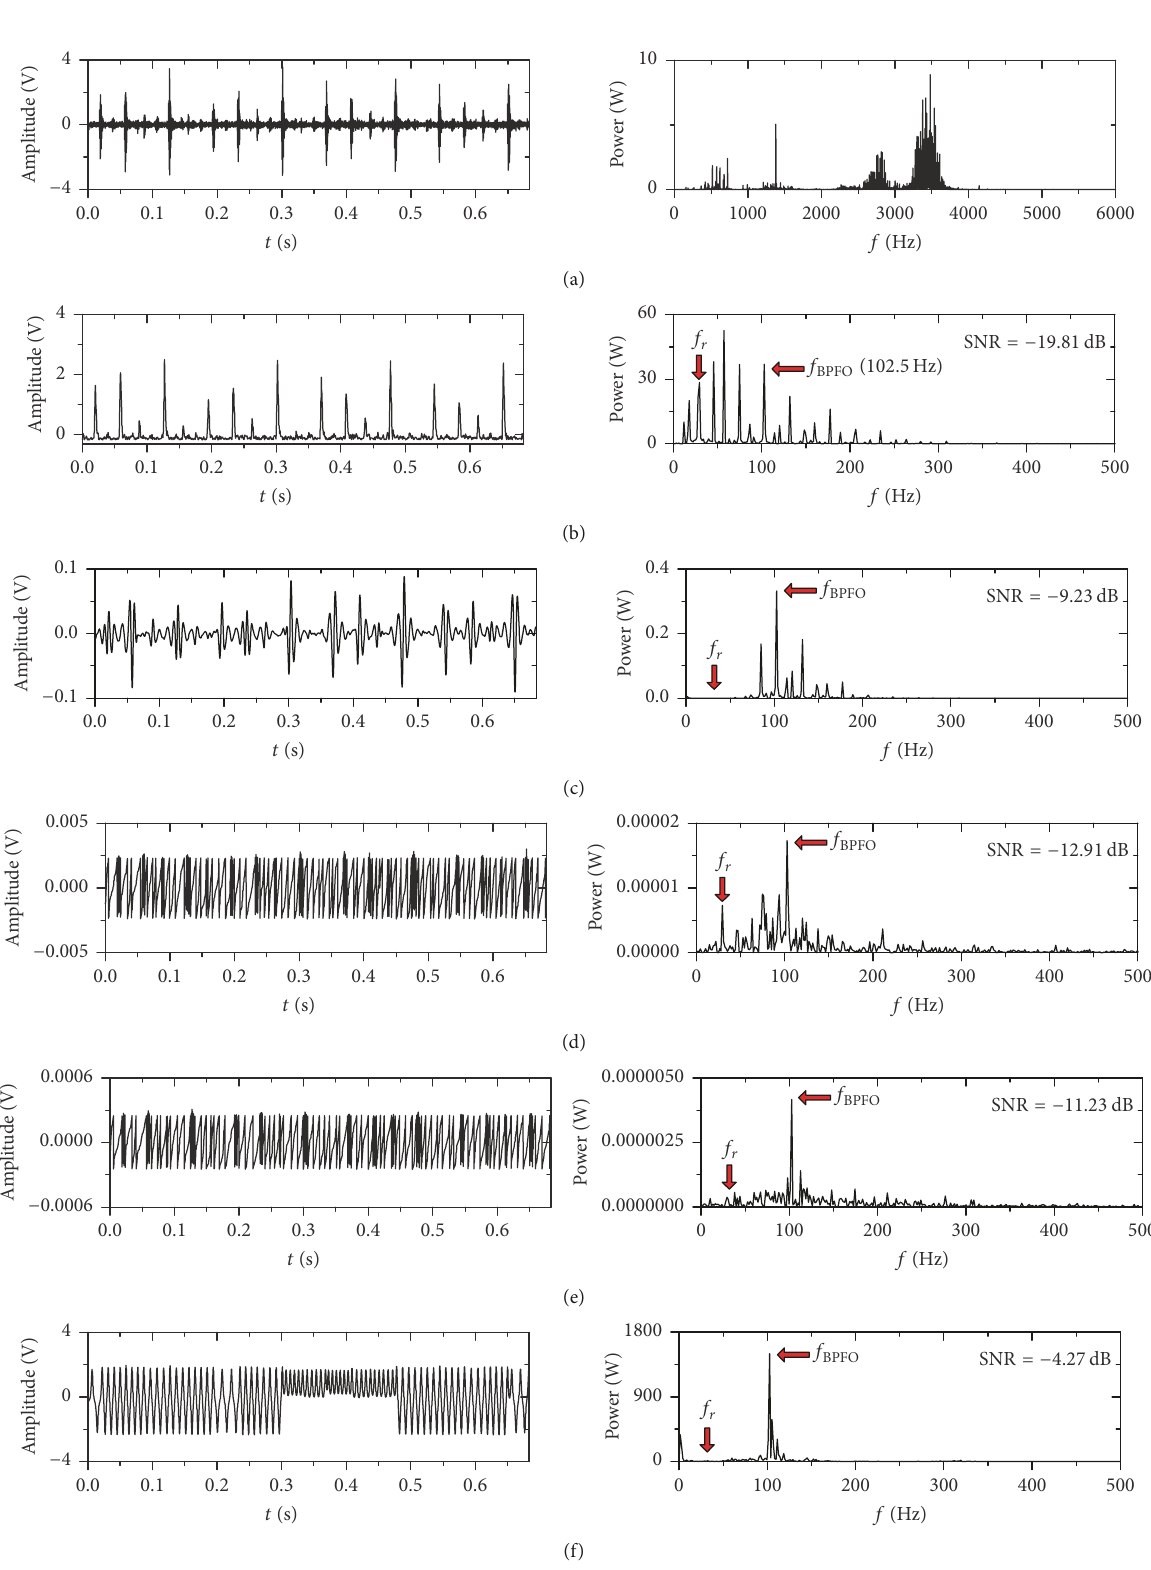
Figure 11: Analysis results for the bearing signal with a defective outer race: (a) original signal; (b) envelope signal with a filtering band at 3000–3750 Hz; (c) optimal MSTSR output signal (optimal parameters: 𝑎 = 0.4 , 𝑏 = 1 , ℎ = 2𝑒−4 , and 𝐾 = 6 ); (d) optimal WSSR output signal (optimal parameters: 𝑅 1 = 0.08 , 𝑉 0 = 36 , 𝑐 = 0.6 , and ℎ = 1𝑒−4 ); (e) optimal WSGSR output signal (optimal parameters: 𝑅 1 = 0.05 , 𝑅 2 = 2.1 , 𝑉 = 25 , 𝑉 = 0.5 , 𝑐 = 0.4 , and ℎ = 4𝑒 − 5 ); and (f) optimal SVVR output signal (optimal parameters: 𝑎 = 7.2 , 𝑏 = 3.8 , 𝛾 = 6𝑒 − 6 , ℎ = 0.03 , 0 1 𝐵 = 4𝑒 − 5 , and Ω = 16736